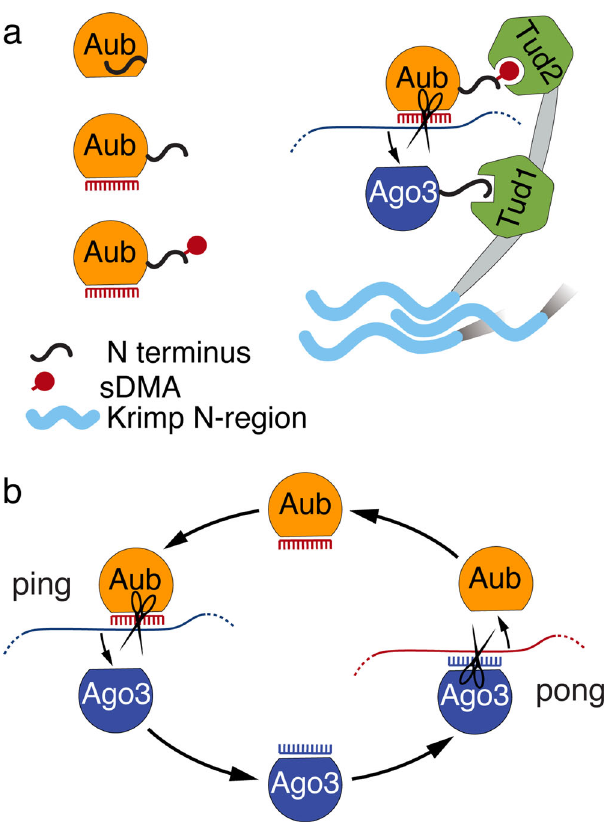
Fig. 7 Model for sDMA regulation and its function in ping-pong cycle. a Model sDMA dependent assembly of the ping processing complex. The N- terminus of unloaded Aub is inaccessible. Binding to piRNA guide leads to a conformational change of Aub exposing its N terminus and enabling methylation of its N-terminal arginines. Methylation thus serves as a signal of loading-state and enables Aub binding to the Tud2 domain of Krimper, which speci fi cally recognizes methylated Arginines. The Tud1 domain of Krimper binds unmethylated, unloaded Ago3, enabling Ago3 loading with the newly processed piRNA. The N-terminal unstructured region of Krimper allows Krimper multimerization resulting in a Krimper scaffold that might assist in nuage assembly and ensuring high local concentration of Aub and Ago3. b The Ping-Pong cycle consists of two distinct stages. In the ping stage, Aub with its piRNA guide targets piRNA precursors or TE transcripts. Cleaved, mature piRNA is loaded into Ago3. In the pong stage, piRNA- loaded Ago3 targets antisense piRNA precursors. Cleaved mature piRNA is loaded into Aub. The ping and pong processing could be accomplished by different complexes in